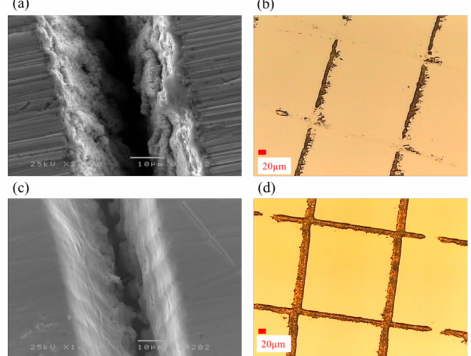
Figure 6. The gravure plate without and with surface treatment of ( a ) before electrolytic polishing; ( b ) bad ink transfer rate of non-treatment gravure plate; ( c ) after electrolytic polishing; and ( d ) good ink transfer rate of electro-polished gravure plate.